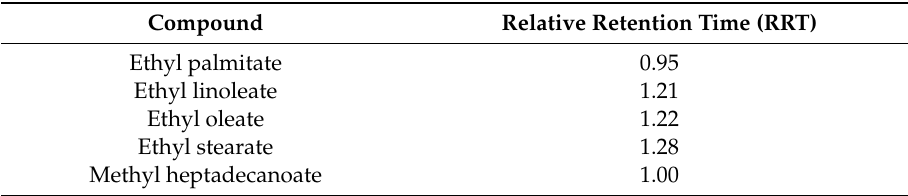
Table 1. Relative retention time (RRT) measured for the fatty acid ethyl esters considered in relation to methyl heptadecanoate (used as internal